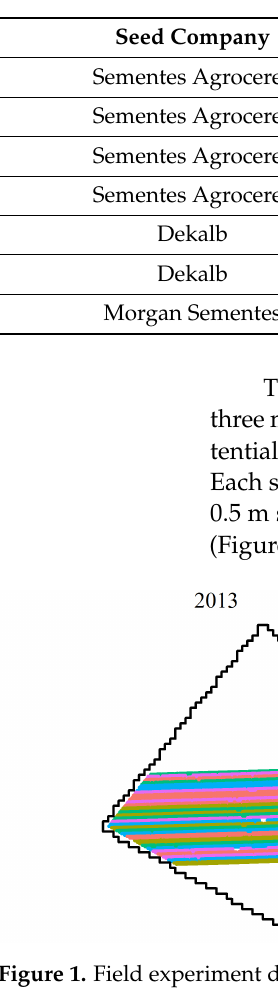
Table 1. Characteristics of maize hybrids.